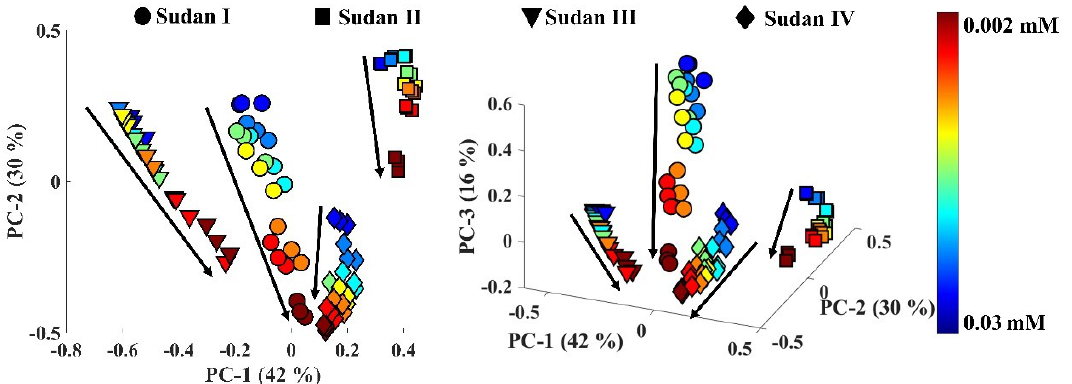
Figure 4. Plot of 2D ( left ) and 3D ( right ) PCA scores for all the SERS spectra of solutions of Sudan I − IV with different concentration (from 0.03 mM to 0.002 mM). A rainbow color bar represented the concentration of the four dyes, which are represented by different symbols. The values on axes in parentheses represent the total explained variance for each principal component (PC).